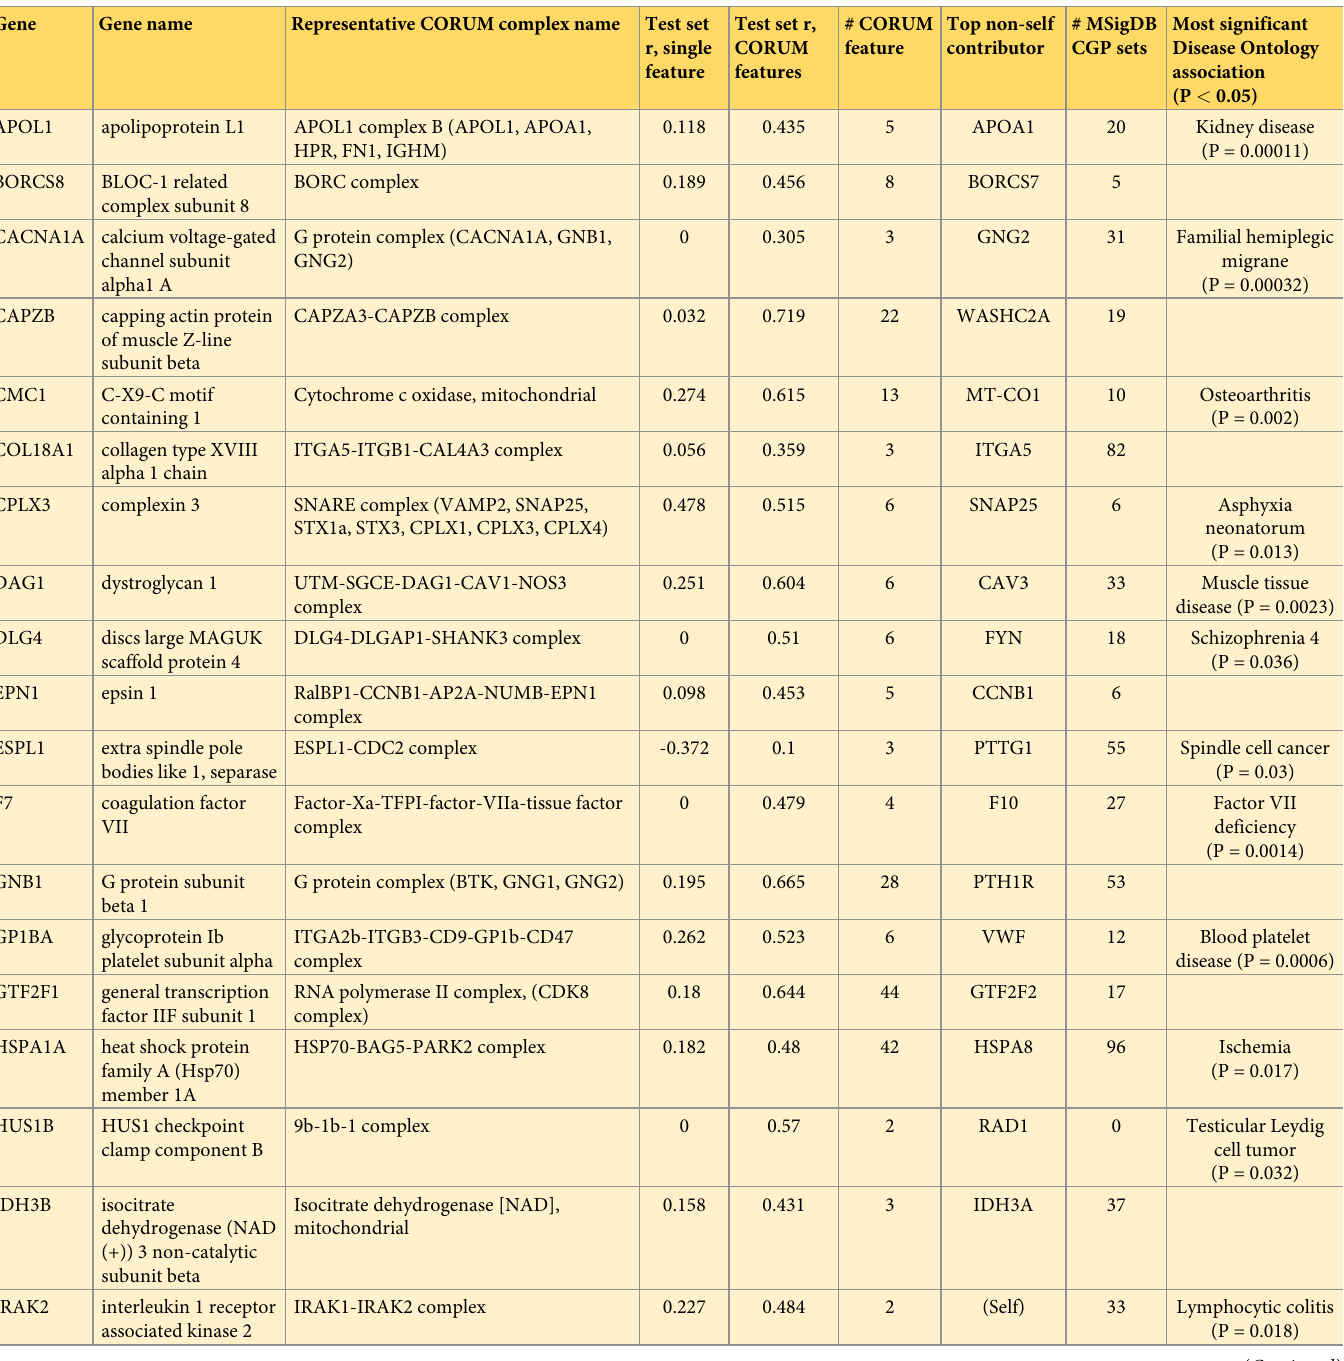
Table 1. Top 50 proteins whose abundance is under substantial influence from non-cognate transcripts. Columns 1 and 2: gene names. Columns 3 show the represen- tative CORUM complex the gene of interest belongs to. Columns 4 and 5 denote the increase in prediction performance between elastic net single feature (self transcript) vs. CORUM feature sets. Column 6 shows the number of transcripts used to predict the protein level of the gene of interest in the CORUM feature set. Column 7 shows the top trans-locus contributor to the protein level of the gene of interest, ranked by absolute coefficients in the elastic net model. Proteins whose own transcripts are the top predictors are marked with (self). Column 8 denotes the number of MSigDB C2 CGP (chemical and genetic perturbation) gene sets in which the gene appears. Column 9 denotes the top significantly associated Disease Ontology term with the gene of interest in the